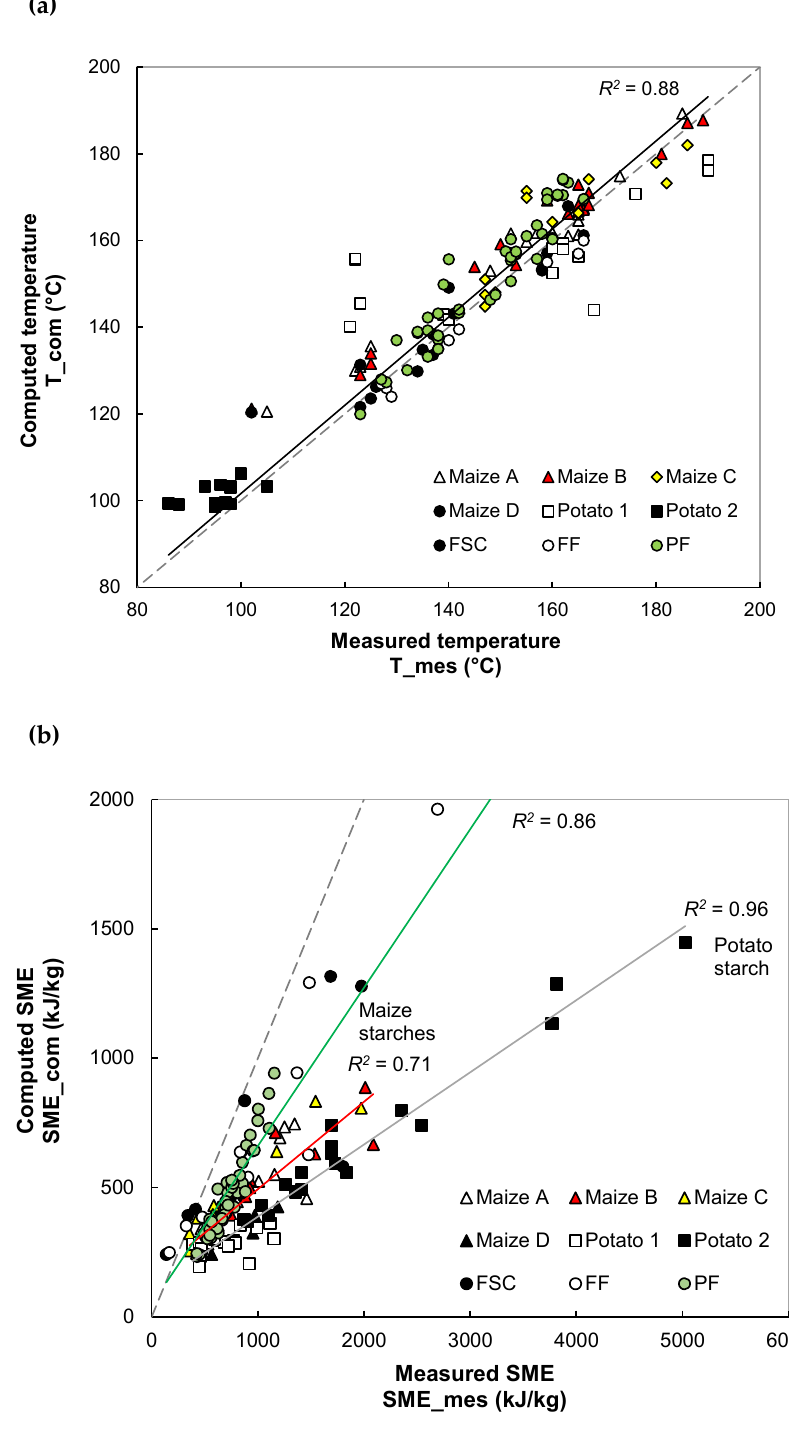
Figure 1. Figure 1. Comparison between predicted and measured extrusion variables: temperature ( a ) and specific mechanical energy (SME) ( b ). The solid lines following linear equations stand for correlation between measured and predicted variables, while the dotted line stands for the equity between